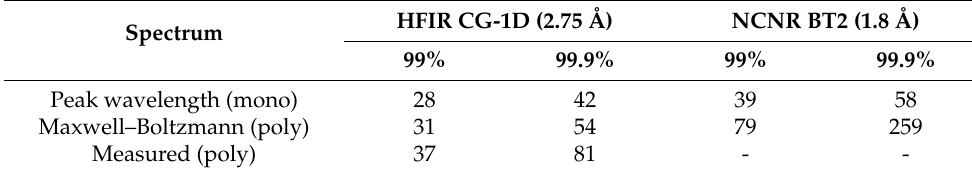
Table 1. Required Gd 2 O 3 thickness ( µ m) to achieve given